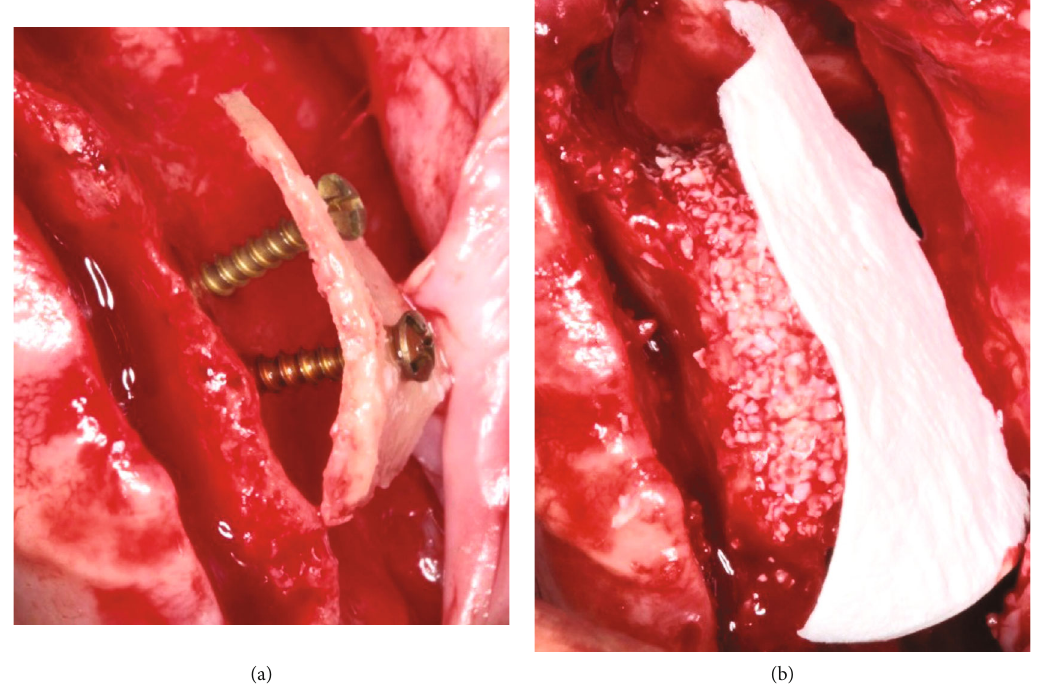
Figure 4: Shell grafting procedure in case no. 2: (a) ZB graft placed at a distance from the recipient site and stabilized with two miniscrews; (b) gap fi lled with 50 :50 mixture (autogenous+xenogeneic) bone particles and covered with a large collagen